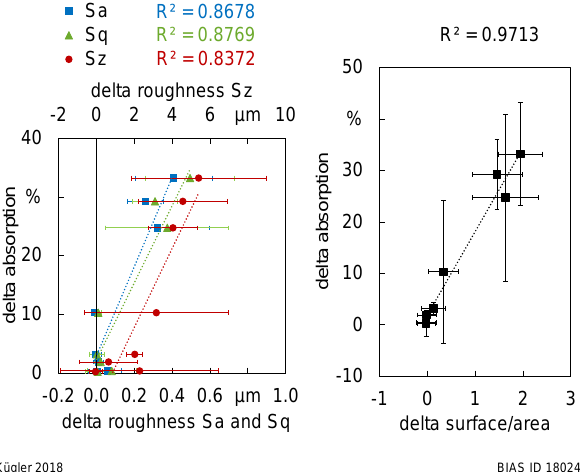
Figure 10. Results of multiple laser processing showing the influence of roughness values ( left ) and the